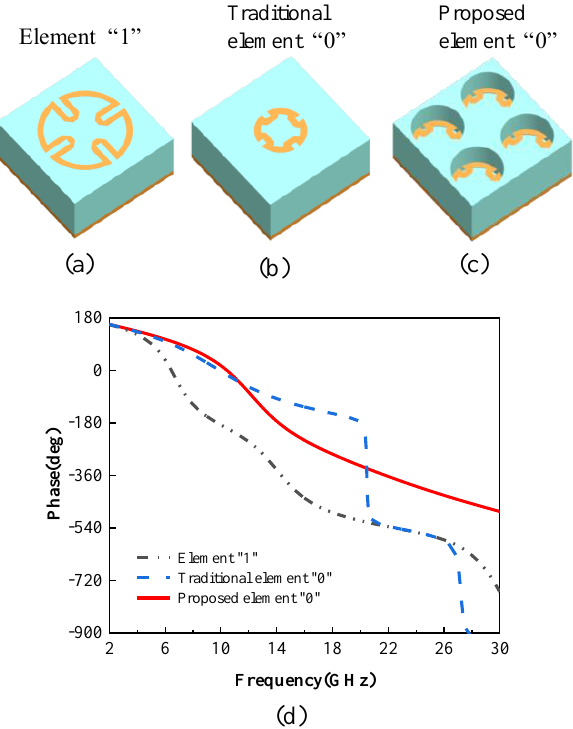
Figure 1. The traditional coding element of the diffusion metasurface. ( a ) The three-dimensional (3D) view of the “1” element. ( b ) The 3D view of the traditional “0” element. ( c ) The 3D view of the proposed period-changed “0” element. ( d ) Phase contrast between the “1” element and traditional “0” element, and the proposed period-changed “0” element.